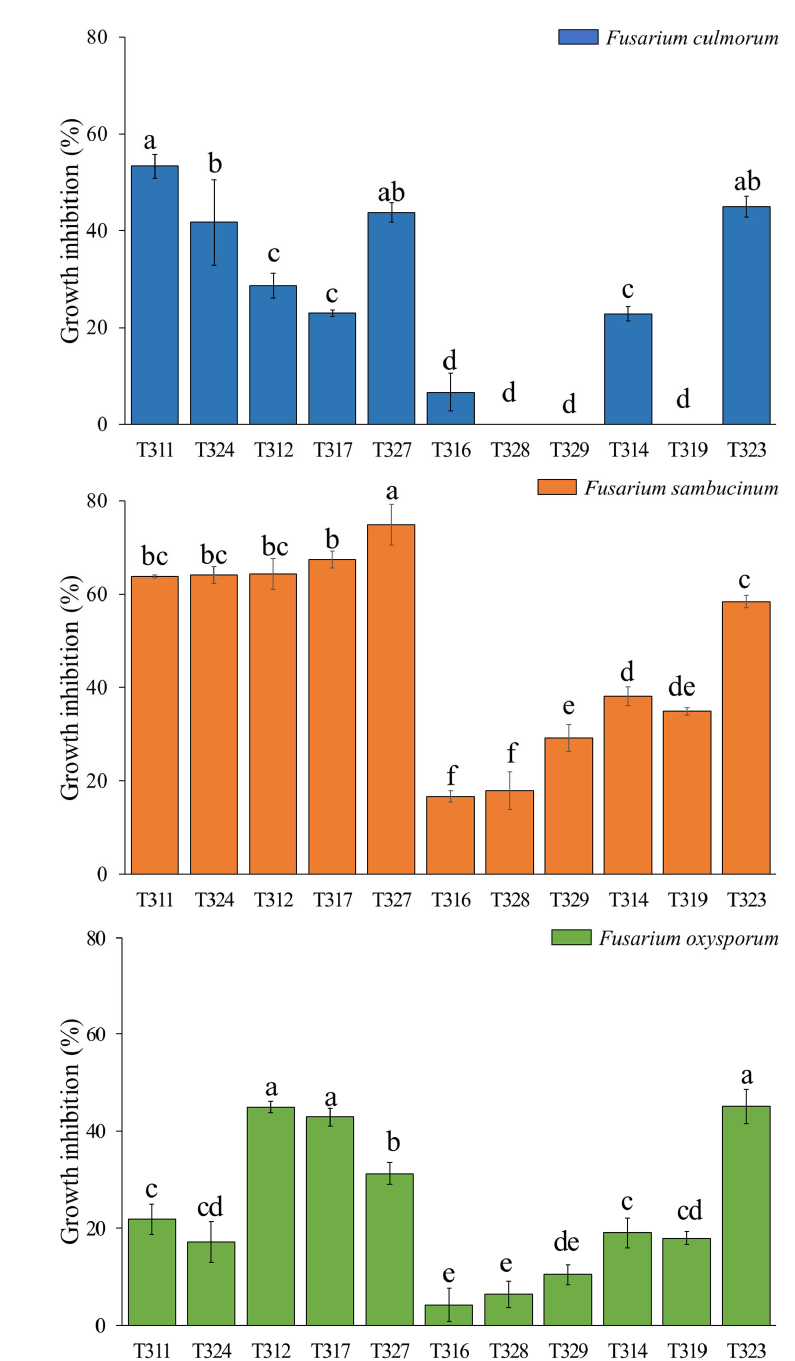
Figure 5. Growth inhibition percentages of the Trichoderma isolates against ( a ) F. culmorum , ( b ) F. sambucinum , and ( c ) F. oxysporum in antifungal membrane assays. Mean values ± SE. Columns within the same chart with different letters indicate significant differences (Fisher’s LSD, p < 0.05). Altogether, F. culmorum and F. oxysporum showed a lower influence by Trichoderma metabolites, whereas F. sambucinum was more susceptible, as the percentages of inhibition had higher values. In general, the metabolite secretion of T. hamatum (T311 and T324)